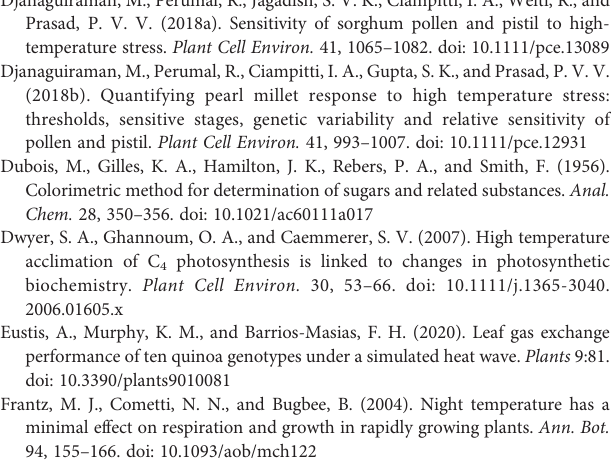
SUPPLEMENTARY FIGURE S1 | Relationship of night respiration with (A) total leaf area (TLA) and (B) speci fi c leaf area (SLA) of two sorghum hybrids (DK 53 and DK 28E) exposed to two mean temperatures (27 and 35°C) (27°C [optimum mean daytime and nighttime temperature; ODNT] and 35°C (high mean daytime and nighttime temperature; HDNT]) with three diurnal temperature amplitudes (2, 10, and 18°C). Coef fi cient of determination (R 2 ) followed by ** corresponding to signi fi cance at P <0.01. Dry weight (DW). SUPPLEMENTARY FIGURE S2 | Relationship of speci fi c leaf area (SLA) with (A) starch, (B) total soluble sugars (TSS) and (C) total biomass (TB) of two sorghum hybrids (DK 53 and DK 28E) exposed to two mean temperatures (27 and 35°C) (27°C [optimum mean daytime and nighttime temperature; ODNT] and 35°C (high mean daytime and nighttime temperature; HDNT]) with three diurnal temperature amplitudes (2, 10, and 18°C). Coef fi cient of determination (R 2 ) followed by ** corresponding to signi fi cance at P <0.01. Dry weight